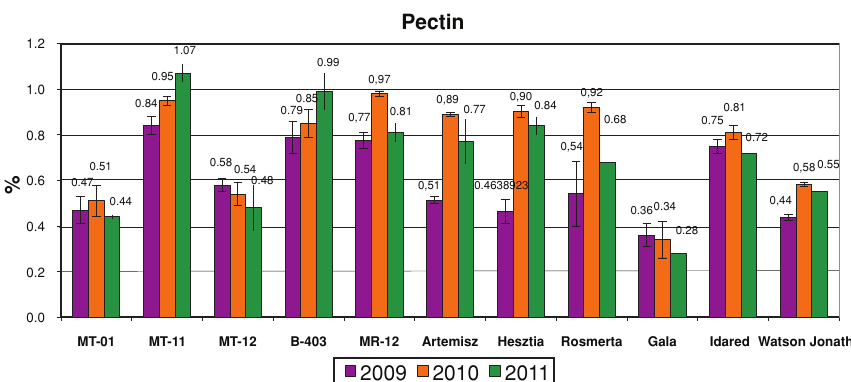
Figure 1. Pectin content of the fruits in eight new and three control varieties (2009–2011)